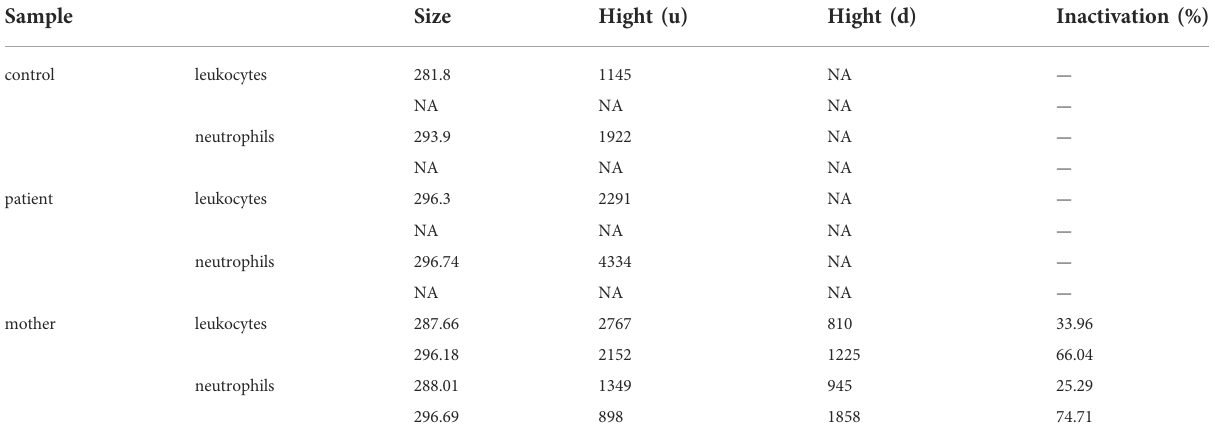
TABLE 2 Results of X chromosome inactivation detection.